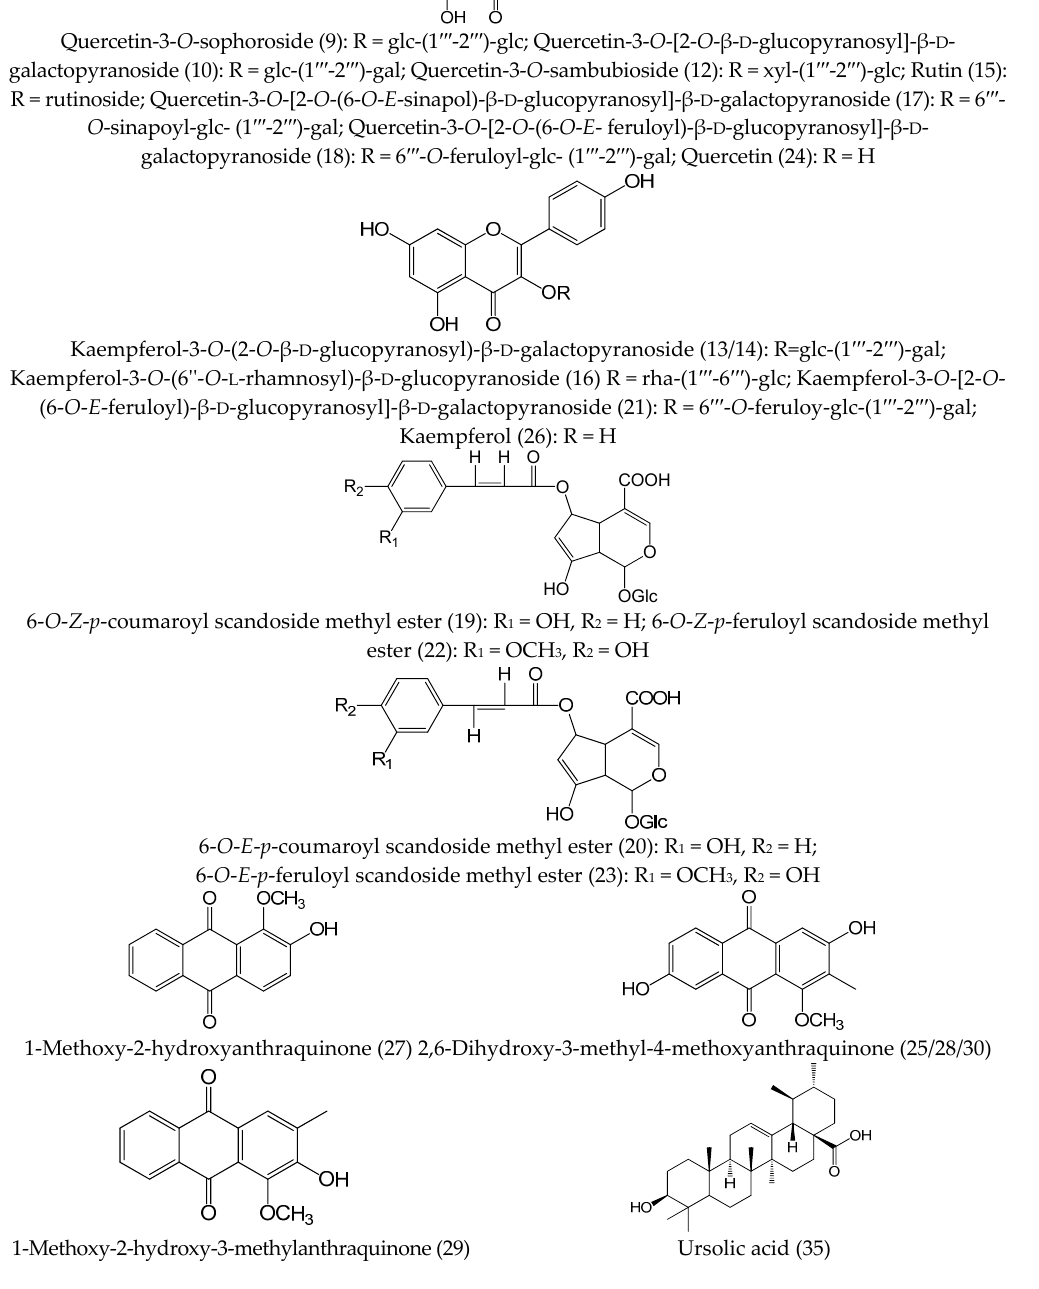
Figure 5. Chemical structures of the compounds identified in H. diffusa extract, mice plasma and kidney.